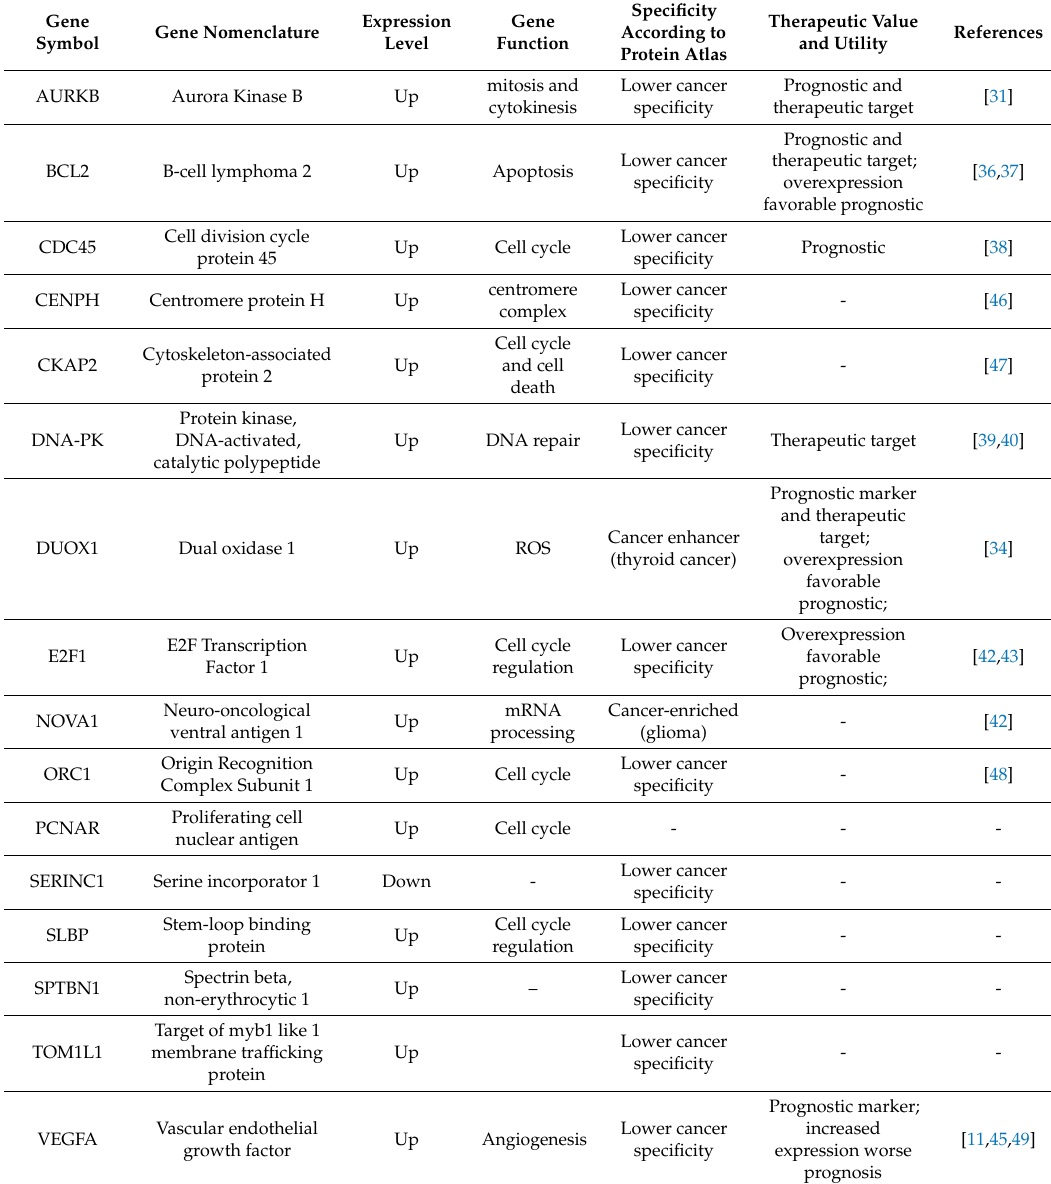
Table 2. Major functions of important prognostic genes related to